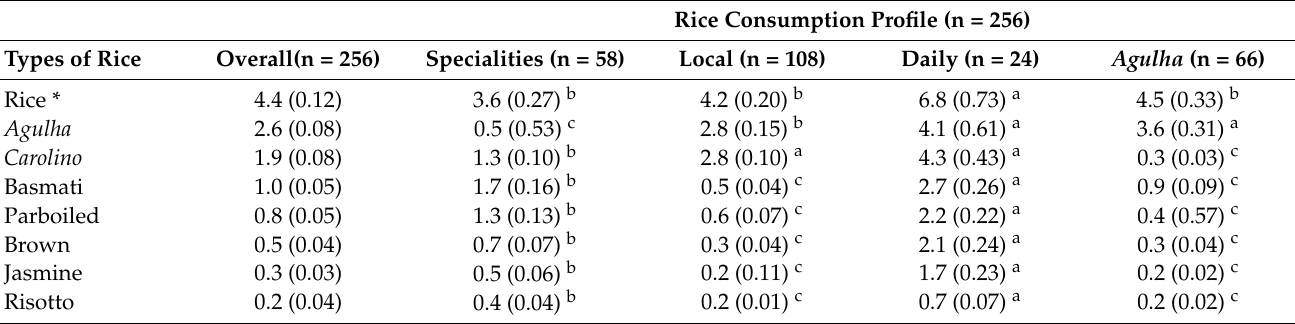
Table 4. Self-reported frequency of consumption of different types of rice (meals/week) by consump- tion profile. Rice Consumption Profile (n = 256)